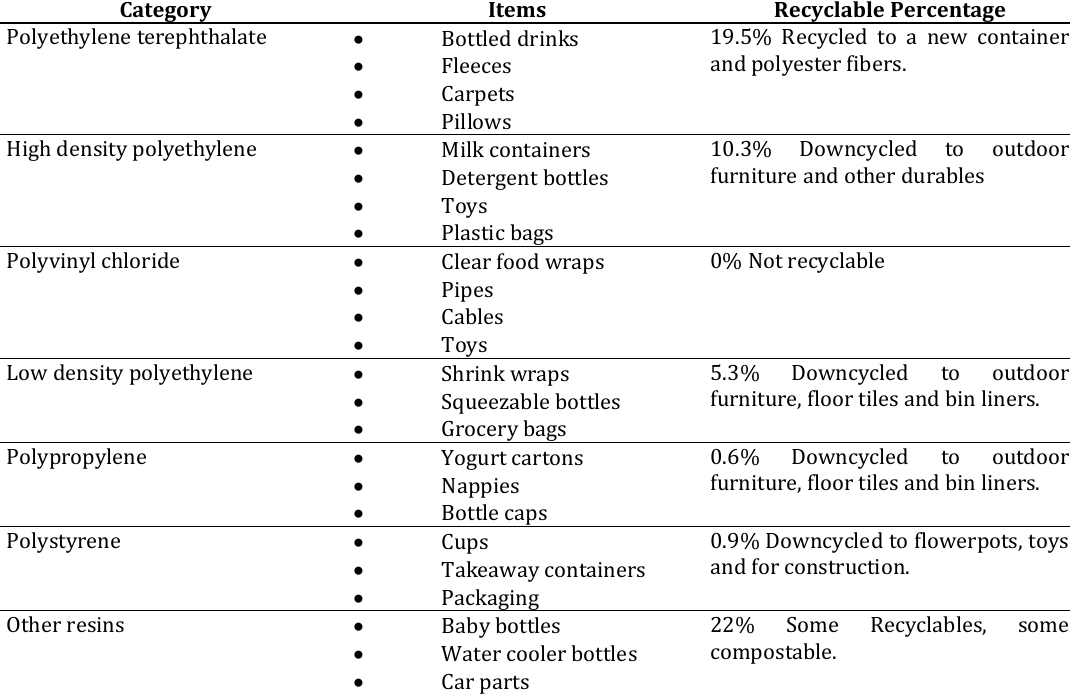
Table 2. Seven different categories of plastics that could be recycled, and the breakdown by percentage